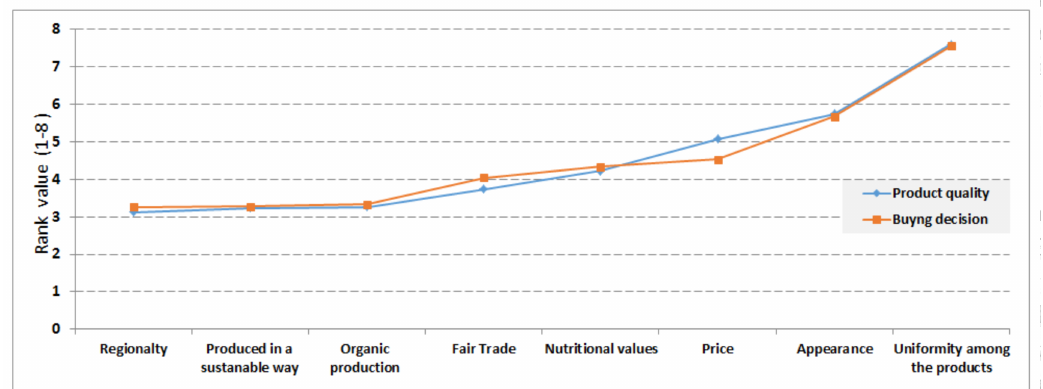
Figure 5. Relationship between perceived product quality and buying decisions. The average ( N = 100) rank values ( Y -axis) were computed for each of the eight parameters (see